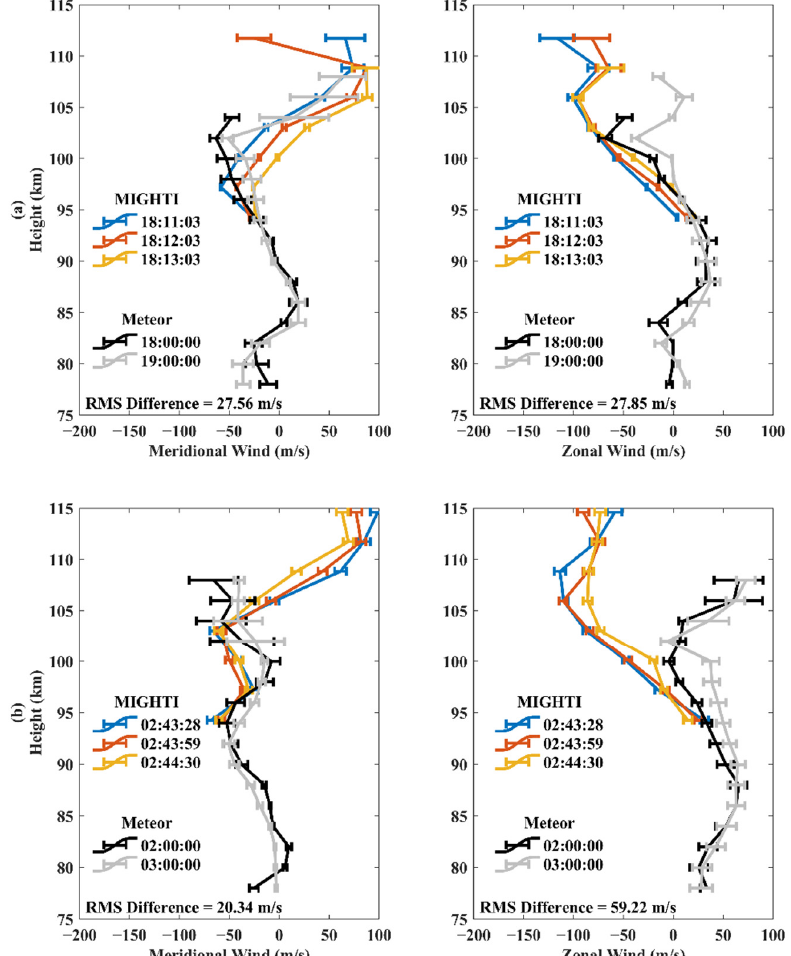
Figure 1. Coincident wind observations for MIGHTI/ICON and meteor radar on 7–8 October 2020. From top ( a ) to bottom ( b ), the measurement time is about 18:00 UT and 02:00 UT, respectively. From left side to right side, they correspond to meridional wind and zonal wind, respectively. The colored lines are MIGHTI/ICON measurements. The black lines and gray lines are meteor radar measurements during the MIGHTI/ICON observations. The error bars are the estimated errors in wind speed.